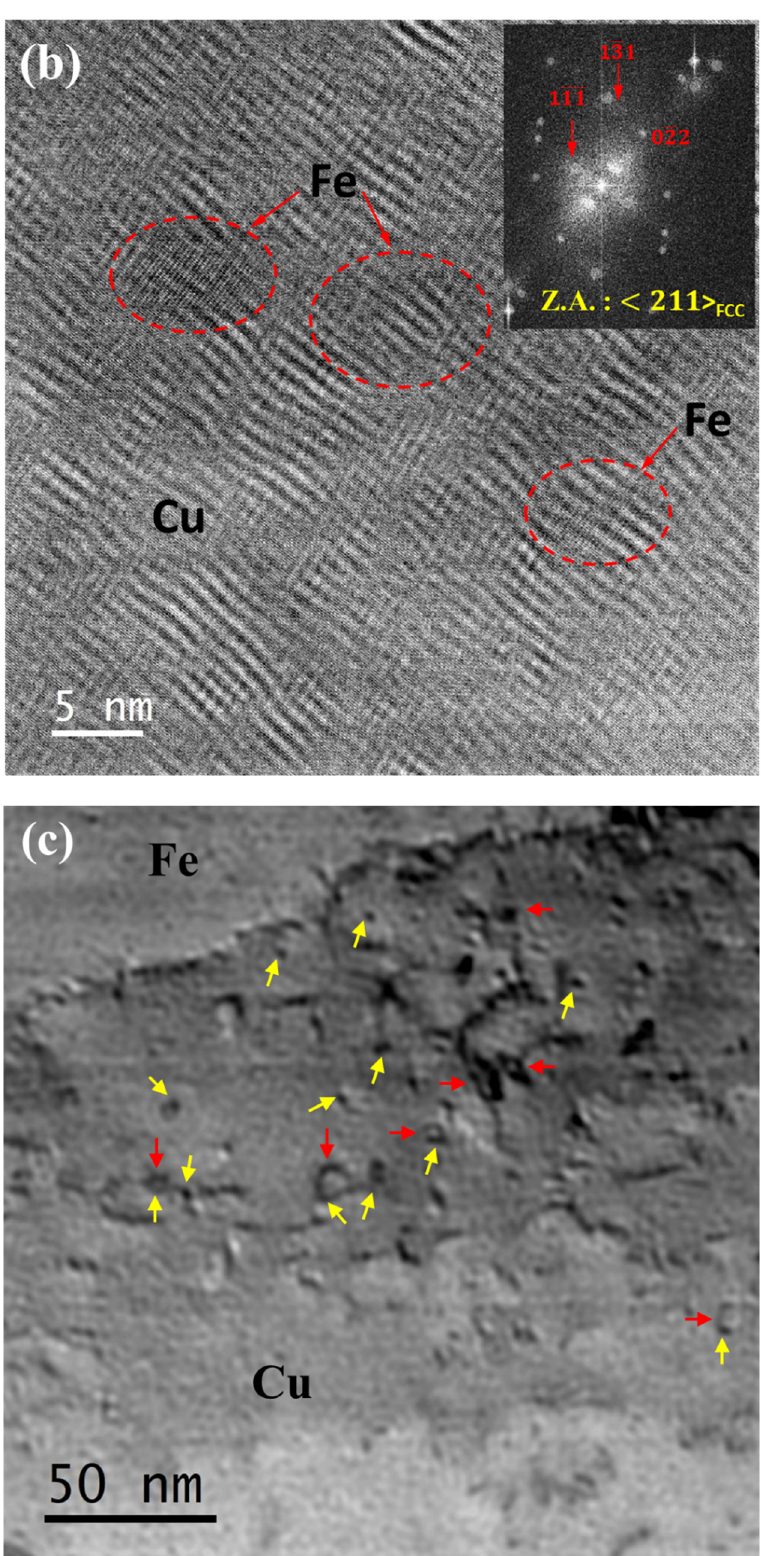
Figure 10. ( a ) Modulated and multiple twinned structures of Fe precipitates (encircled by red dotted lines) in Cu grains after high pressure (i.e., at 18.3 GPa) deformation. ( b ) Apart from modulated Fe precipitates, Cu matrix regions with modulated configuration. ( c ) Formation of dislocation loops around Fe precipitates at stress level (i.e., at 11.3 GPa) below the onset of phase transformation of Fe.